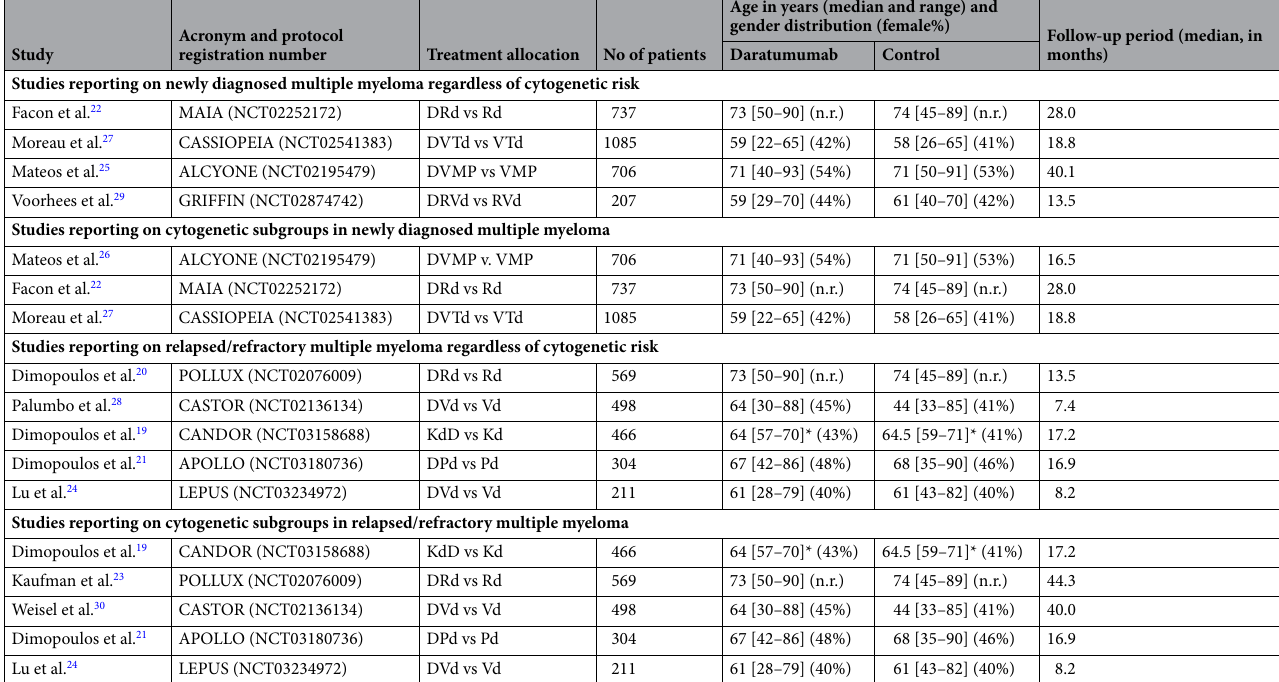
Table 1. Characteristics of the studies included. DPd, daratumumab, pomalidomide and dexamethasone; DRd, daratumumab, lenalidomide and dexamethasone; DRVd, daratumumab, bortezomib, lenalidomide and